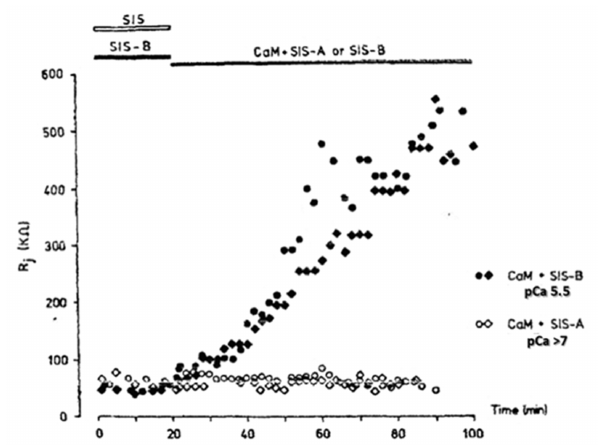
Figure 1. Changes in Junctional Resistance (Rj) in crayfish lateral giant axons in which one axon of the coupled pair was internally perfused with either of the following Standard Internal solutions (SIS): SIS (no added Ca 2+ , 0.1 mM EGTA, pH 7.1); SIS-A (no added Ca 2+ , 10 mM EGTA, pH 7.1, pCa > 7); SIS-B (1 mM CaCl 2 , 0.1 mM EGTA, pH 7.1, pCa 5.5); CaM + SIS-A or SIS-B (10 µ M